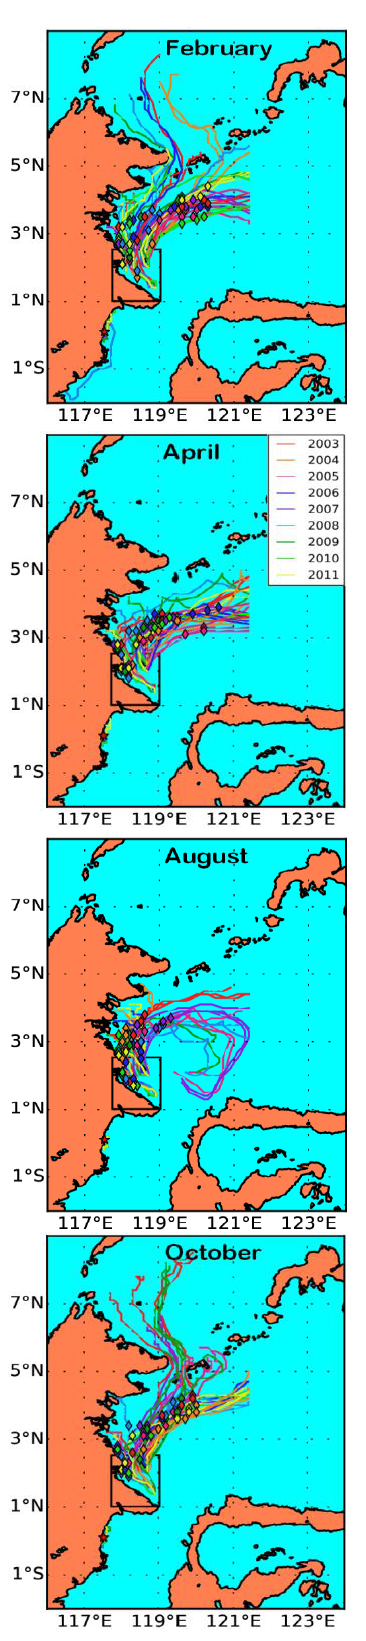
Figure 12. Same as Figure 11, but for the MPA "Berau", northwest of Makassar Strait entrance (marked by a black rectangle), and "Bontang" in the northwestern Makassar Strait (marked by a red